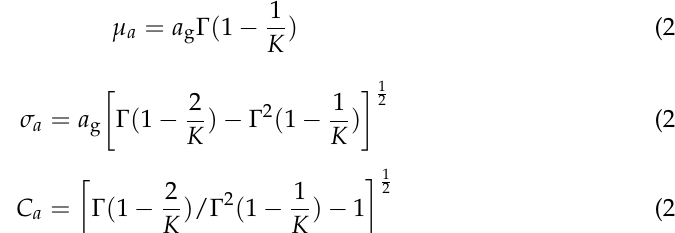
Table 1. Earthquake records.